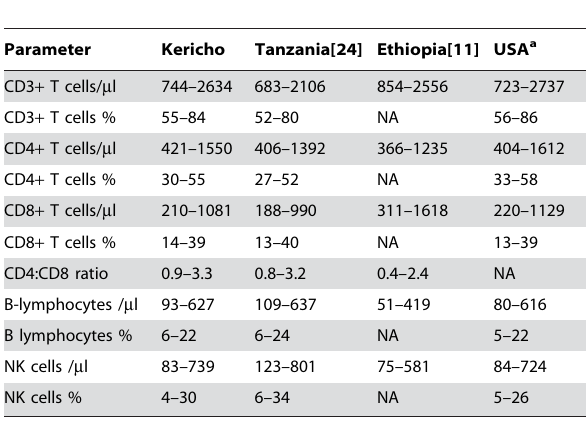
Table 4. Comparison of Lymphocyte Reference Ranges from Kericho, Kenya with those from other